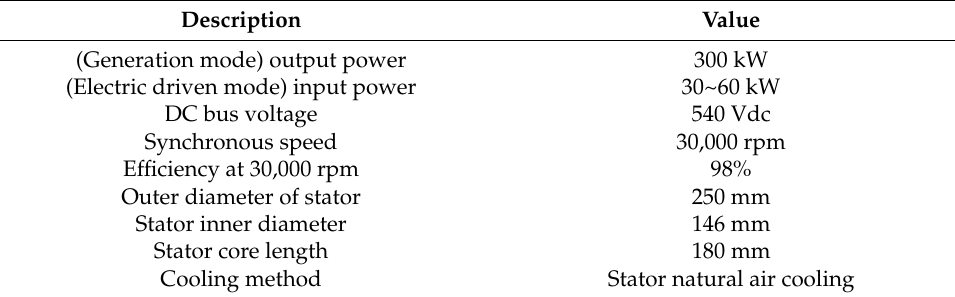
Figure 1. Schematic diagram of flywheel energy storage system. Table 1. Motor technical specifications.